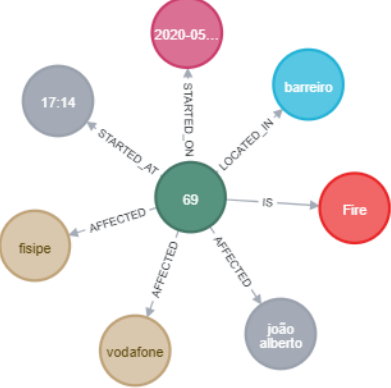
Figure 5. Knowledge graph after the first 5